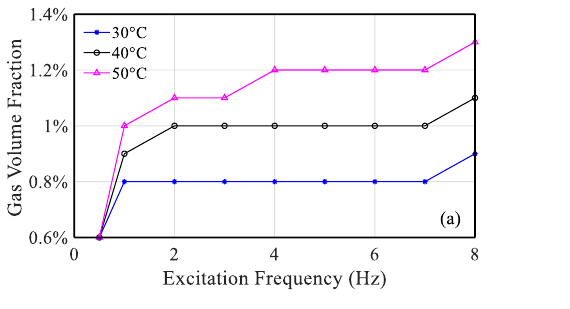
Figure 10. Variations in fluid properties: ( a ) gas fraction within the emulsion, ( b ) discharge coefficients of bleed orifice and check valve.